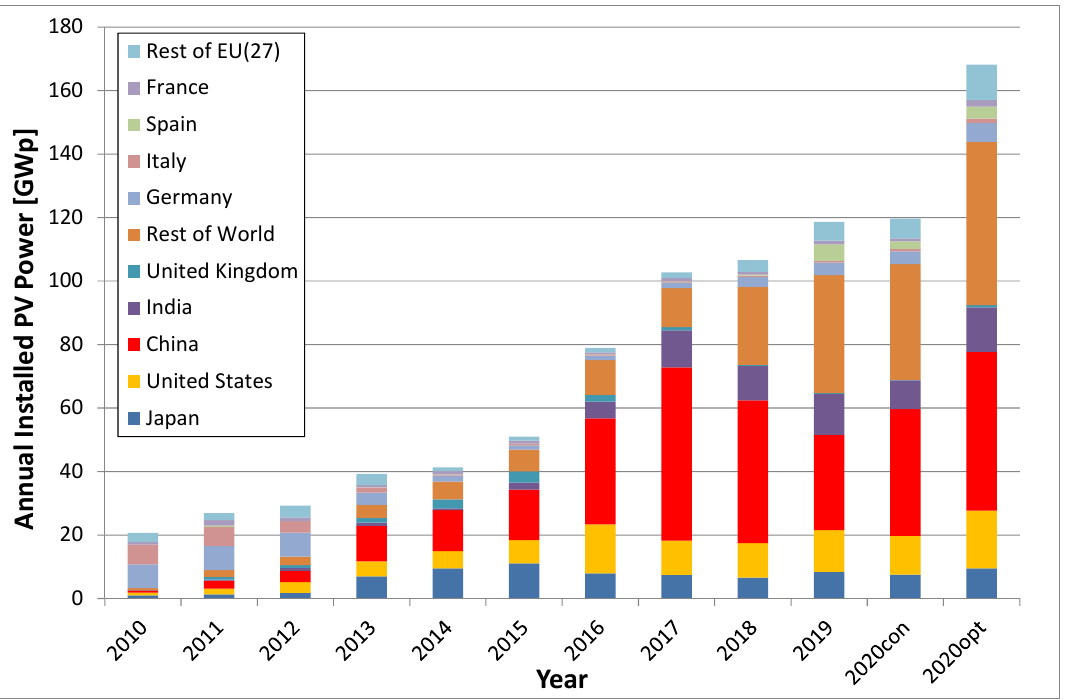
Figure 3. Cumulative Photovoltaic Installations from 2010 to 2020 (data source: [11–13] and own analysis).